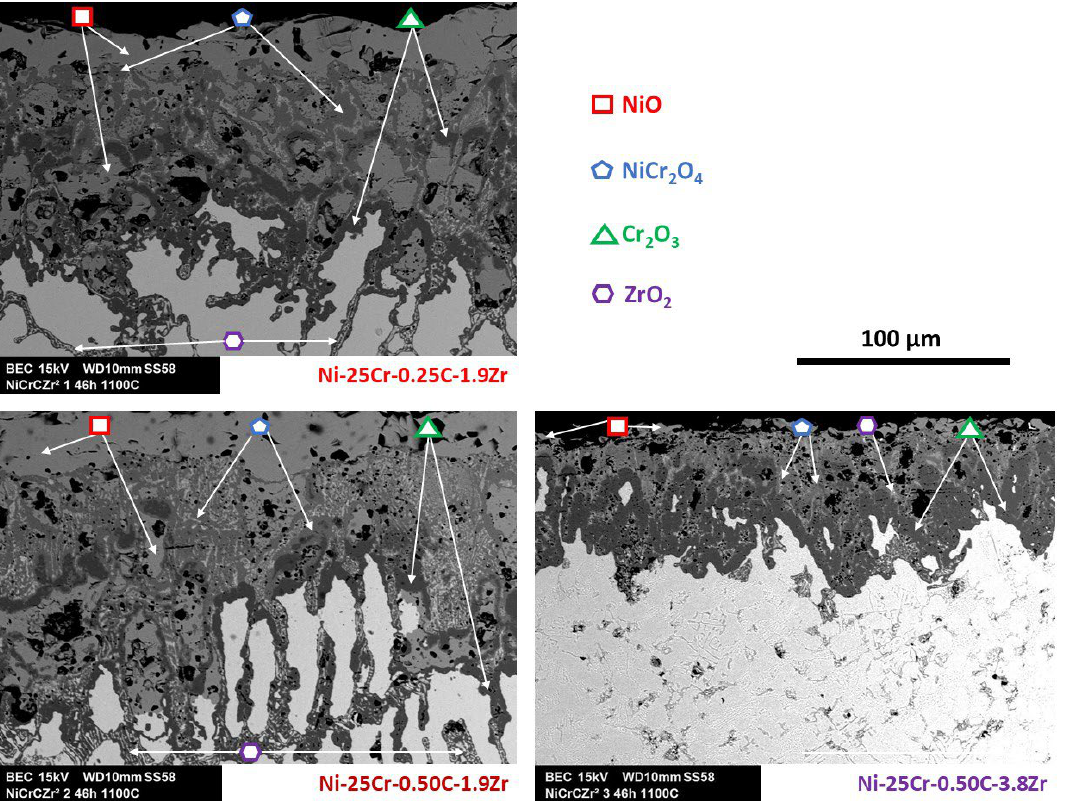
Figure 8. SEM/BSE micrographs of the external oxide scales of the three Zr–containing alloys ( top : the Ni–25Cr–0.25C–1.9Zr alloy, bottom left : the Ni–25Cr–0.50C–1.9Zr alloy, bottom right : the Ni–25Cr–0.50C–3.8Zr alloy).